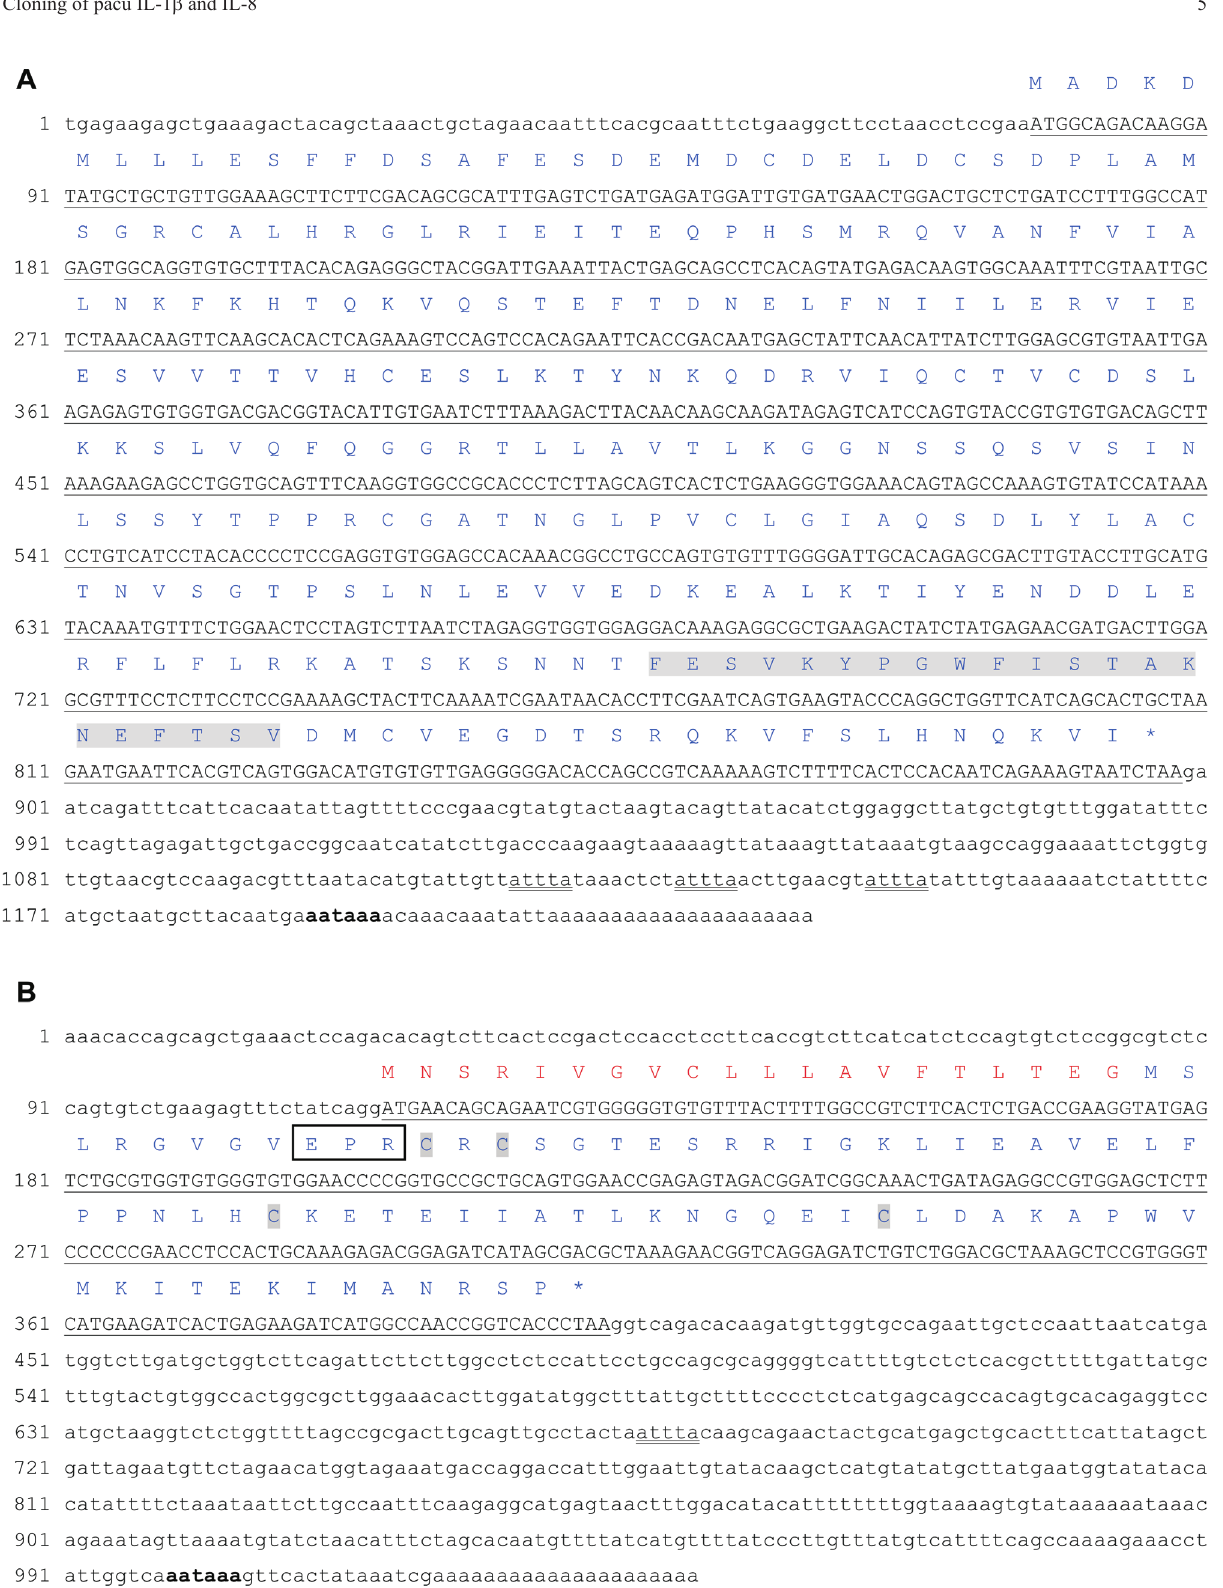
Figure 1 - Full-length cDNA sequence of pmIL-1 (cid:2) (A) and pmIL-8 (B) with deduced amino acids. The ORFs are underlined and shown in uppercase let- ters and the 5’ and 3’ UTRs are shown in lowercase letters. (A) The IL-1 family signature is highlighted in grey. Three instability motifs (ATTTA) are double underlined and the polyadenylation signal sequence (AATAAA) 19 nt upstream the poly A tail is in bold. (B) The putative signal peptide is shown in red. The four conserved cysteines are highlighted in grey. The EPR motif is indicated by a black box. A single instability motif (ATTTA) is double un- derlined and the polyadenylation signal sequence (AATAAA) 21 nt upstream the poly A tail is in